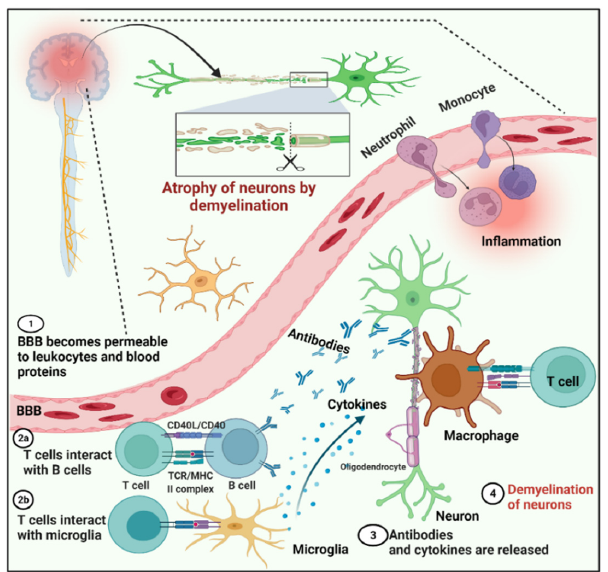
Figure 1. General schematic representation of the mechanism of the autoimmune disorder multiple sclerosis. Steps: 1, The blood–brain barrier becomes permeable to leukocytes and blood proteins. 2, T cells interact with B cells, and T cells simultaneously interact with microglia and induce both types of cells. 3, In response to T cells, microglia and B cells produce cytokines and antibodies, respectively, against myelin. 4, Neuron demyelination